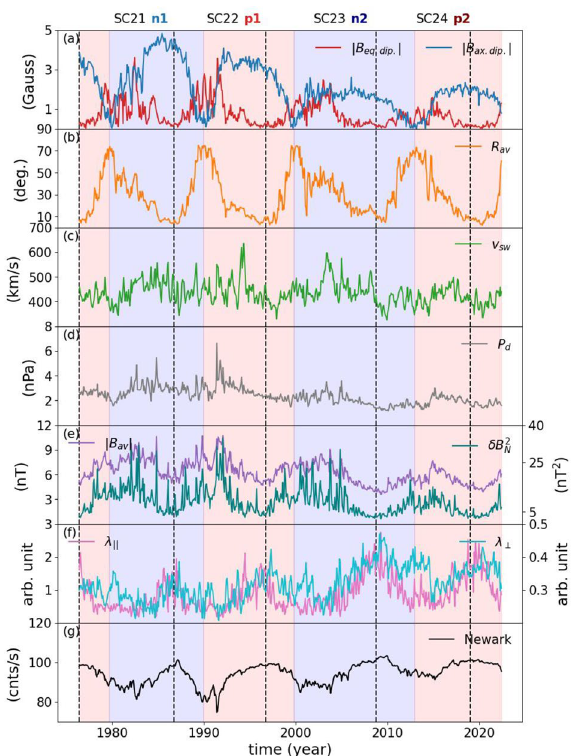
Figure 1. Panel ( a ) displays the magnitudes of the axial (blue) and equatorial (red) dipolar magnetic fields. Panel ( b ) shows the average tilt angle of the HCS and the average solar wind speed is shown in panel ( c ). Panel ( d ) shows the solar wind dynamic wind pressure, while panel ( e ) shows the field magnitude average (purple), and the variance in the north-south component in the HMF (teal). Panel ( f ) shows the parallel (pink) and perpendicular (cyan) MFPs of the particles. Panel ( g ) shows the Newark NCRs. The blue and red shaded areas show when the HMF has negative and positive polarities, respectively. The vertical dashed lines indicate the solar minimum dates. We also note the solar cycles and the positive and negative polarity